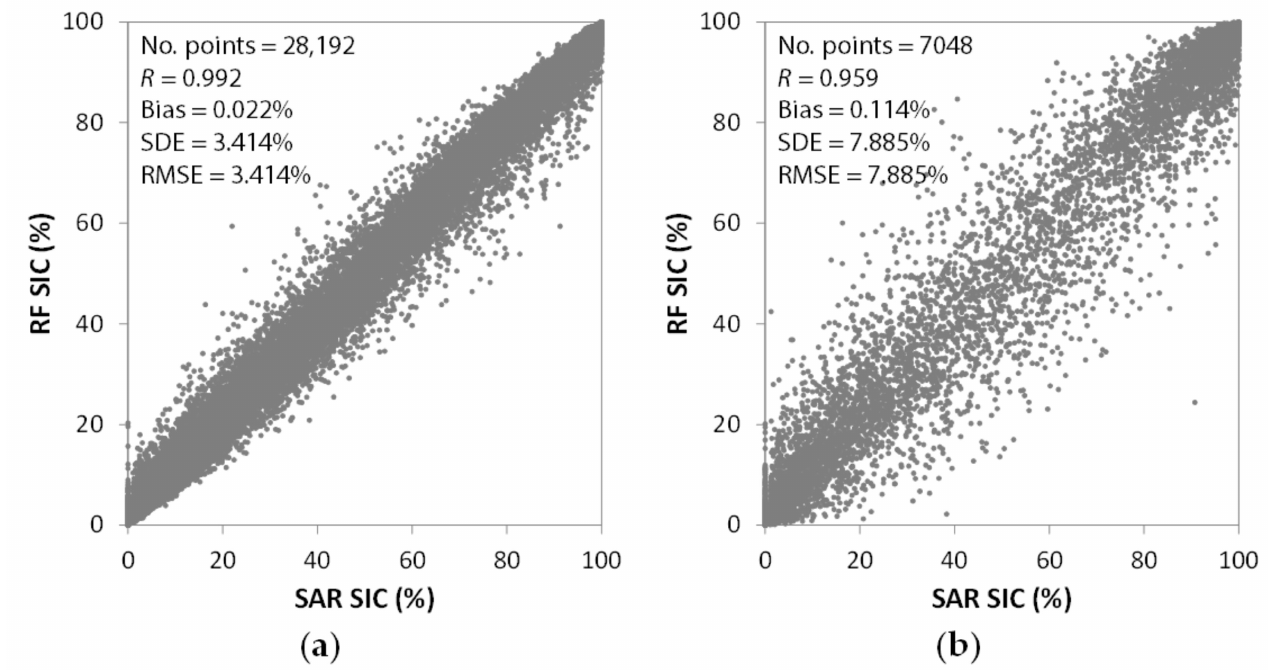
Figure 4. Comparisons of SIC values computed from the KOMPSAT-5 ice/water maps with those predicted by the RF model for the ( a ) training and ( b ) validation datasets.